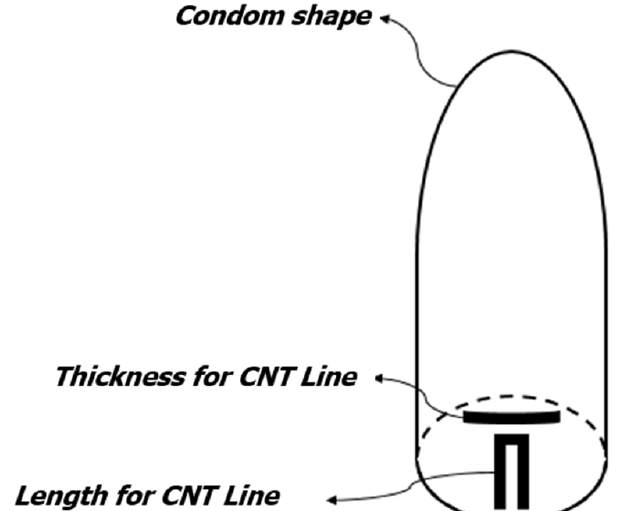
Figure 3. Diagram of the erection measurement sensor. CNT strip to measure length; CNT strip to measure thickness.